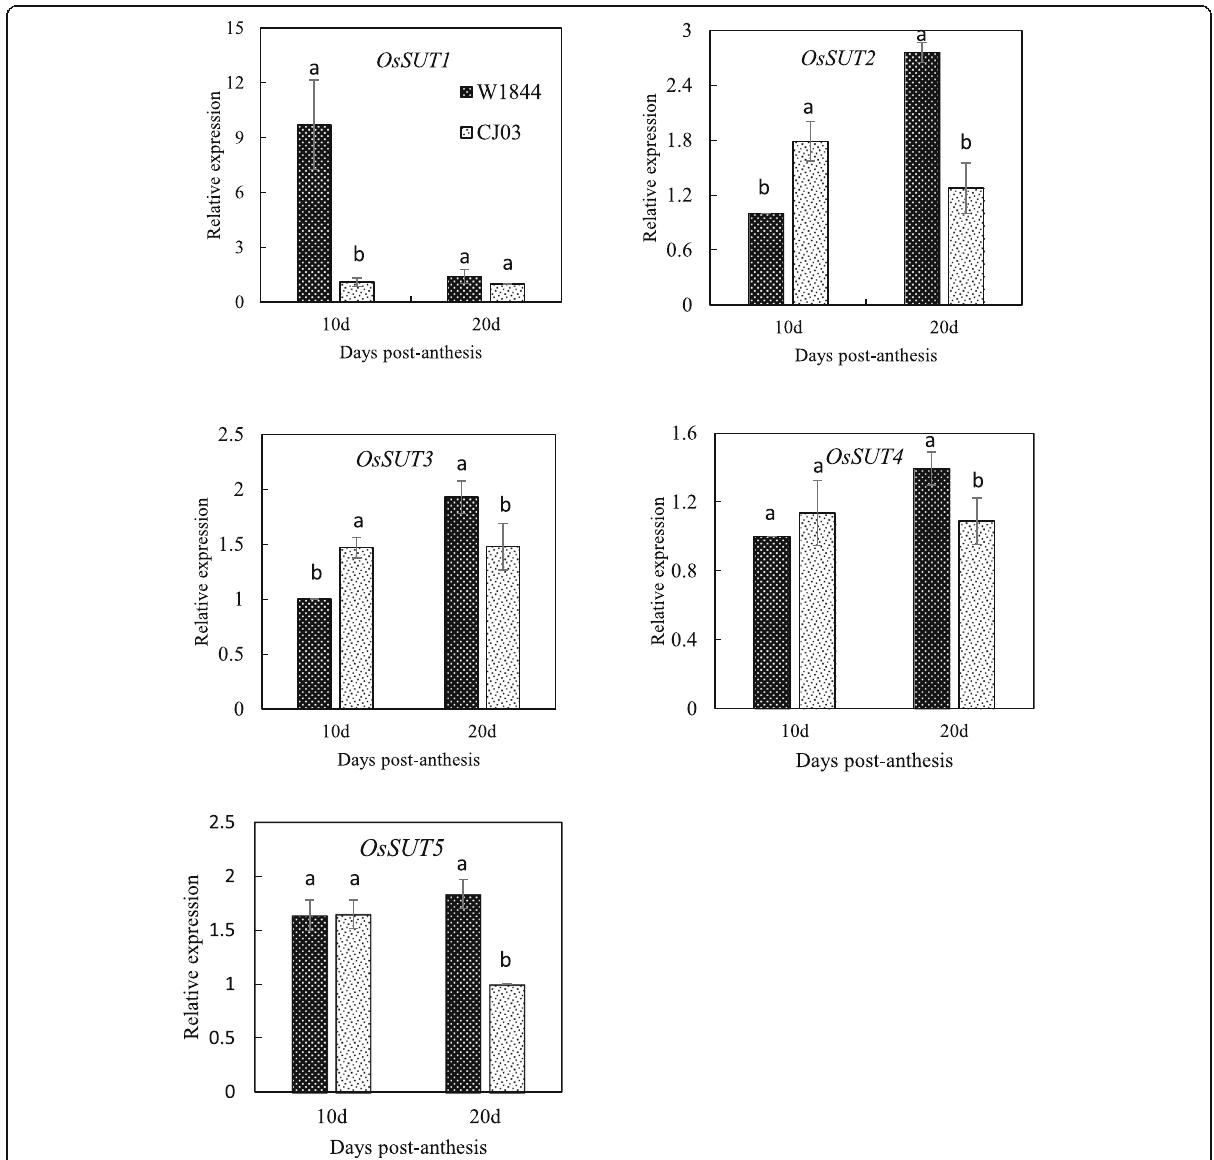
Fig. 5 Relative expression levels of OsSUTs in the the top three leaves at the early filling stage. Data are presented as means ± SE of three biological replicates. Significant differences at each time point are indicated by different letters ( P < 0.05) as determined by Duncan ’ s